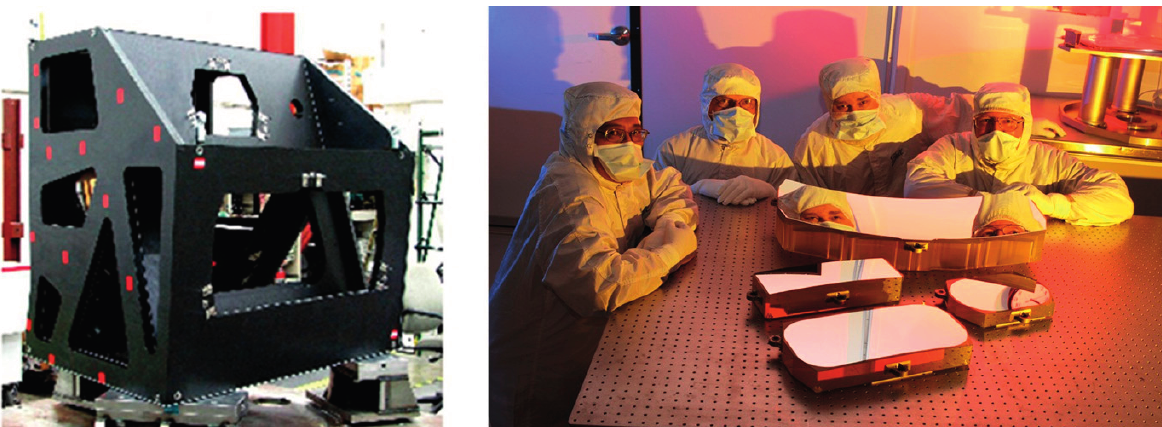
Figure 6. The telescope bench, prior to the installation of optics ( left ); the telescope mirrors, with the engineers and technicians that built them ( right